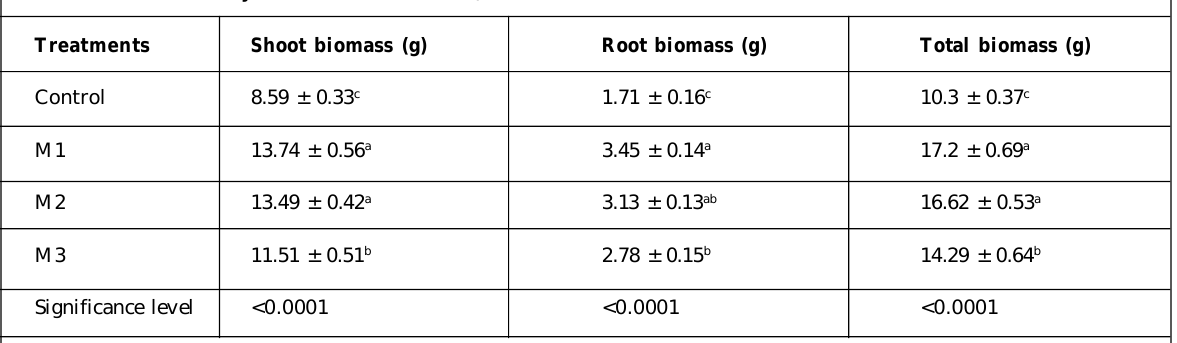
Table 2: Sclerocarya birrea shoot, root and total biomass 9 months after the sowing of Sclerocarya birrea inoculated with 5 mycorrhizal inocula (M1, M2 and M3)